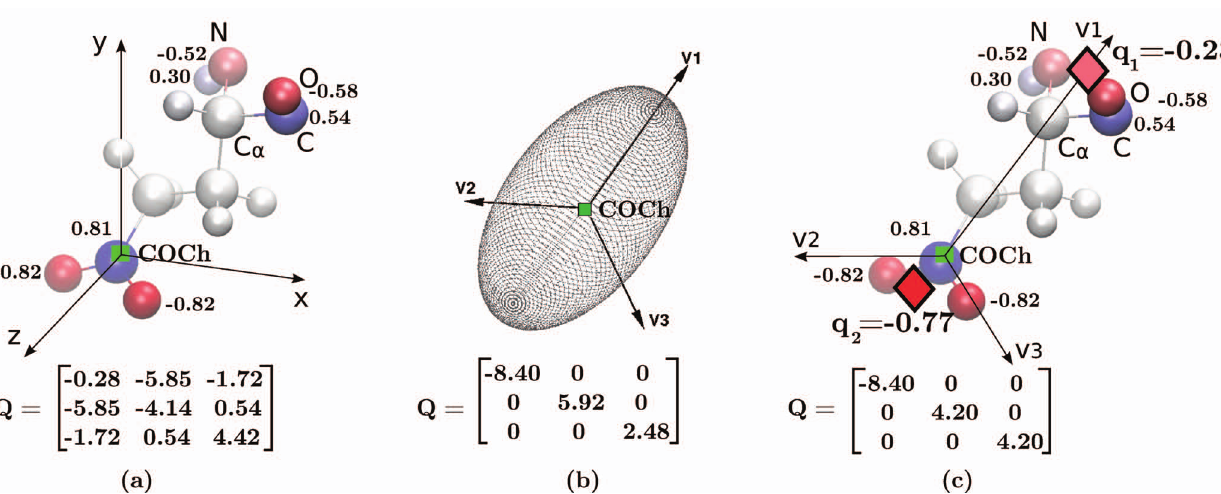
Figure 3. Illustration of a 2-charge practical point charge approximation (PPCA). For a sample charge distribution with non-zero net charge (a glutamic acid group within a protein with net charge ~{ 1 e , where the group includes the associated NH-CH-CO backbone atoms). ( a ) The original charge distribution with its quadrupole tensor (Eq. (5)) shown below. The atomic partial charges are represented as spheres rendered using VMD [21]. The sphere colors range from red to blue representing the charge range of { 1 e to z 1 e . The charge values for partial charges D q D w 0 : 2 e are shown next to the atoms. As a visual reference, the backbone heavy atoms are labeled and covalent bonds are included in the figure. The green square shows the center of charge (COCh). ( b ) The principal axes, v1, v2, v3 of the original charge distribution with the center of charge as origin (green square). Its quadrupole tensor, with the coordinate system aligned to the principal axes (Eq. (27)), is shown below. Here v1 is the principal axis with the largest principal value. Analogous to the concept of ellipsoid of inertia in Mechanics used to characterize mass distribution, an ‘‘ellipsoid of charge’’ can be imagined here that helps visualize the charge distribution characterized by the quadrupole tensor. ( c ) The 2-charges of the PPCA (red diamonds) are placed such that the quadrupole moment for the PPCA equals the component of the quadrupole moment for the original charge distribution along v1 . The quadrupole tensor produced by the 2-charge PPCA, with the coordinate system aligned to the principal axes, is shown below. The values of charges are in atomic units ( e ), and e : A˚ 2 is the unit for the quadrupole tensors. doi:10.1371/journal.pone.0067715.g003 The electrostatic potential was calculated in the mid-field (for two at the center of geometry. The spherical surface was discretized values: R ~ 10 A˚ & 2 R 0 and R ~ 15 A˚ & 3 R 0 ) where the approx- into 7200 grid points at which the electrostatic potential was imation is likely to be least accurate. The electrostatic potential calculated. The RMS error was calculated over all grid points and was computed at discrete points on a sphere of radius R , centered